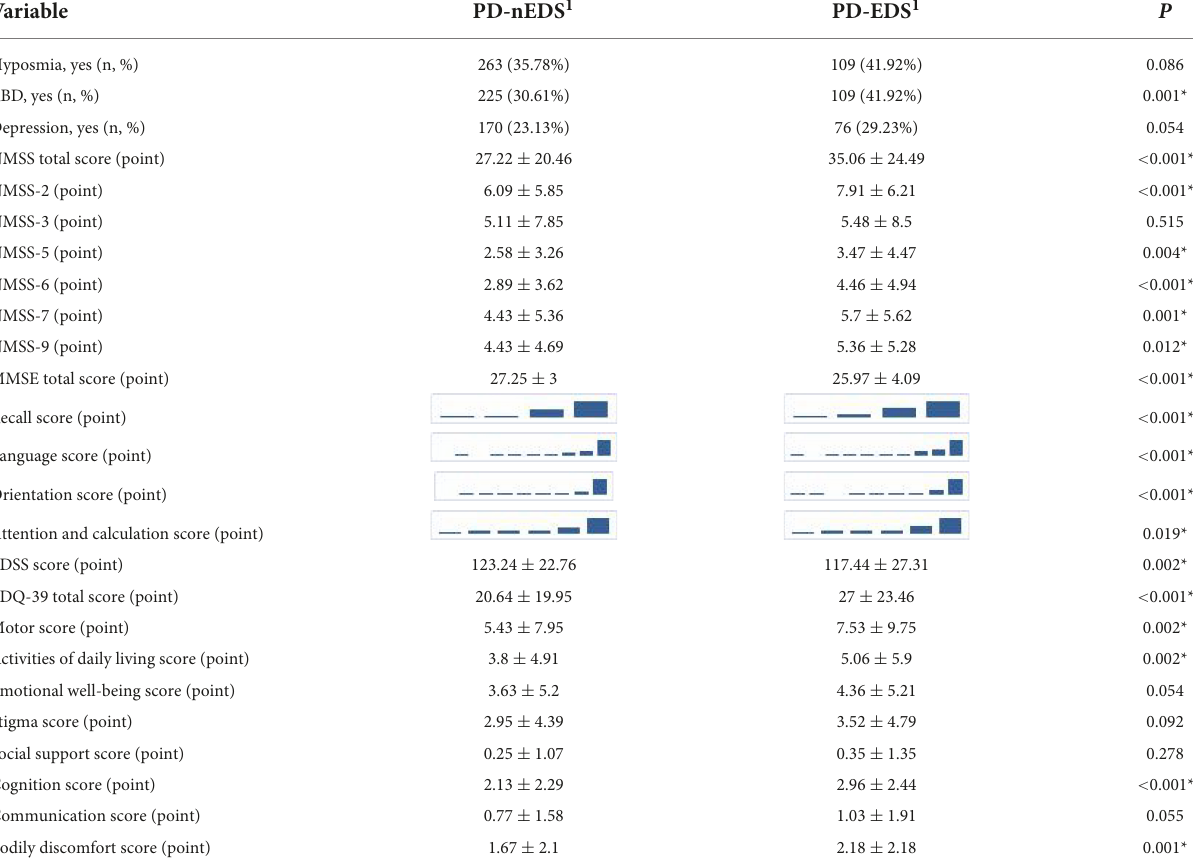
TABLE 3 Comparison of non-motor symptoms between the PD-EDS 1 and PD-nEDS 1 groups.